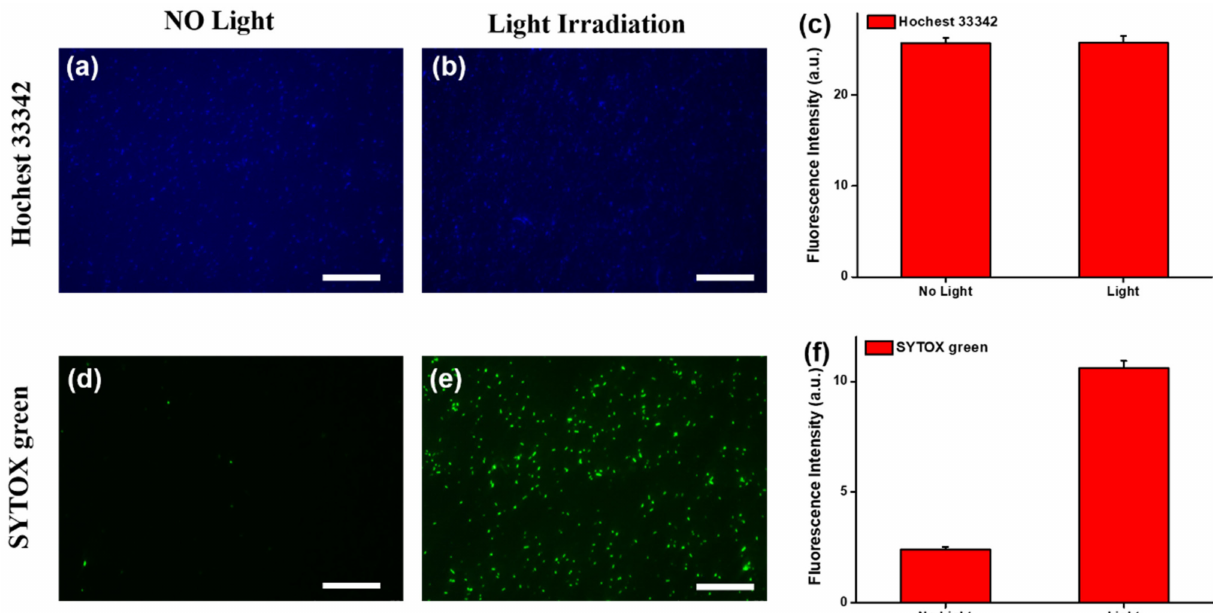
Figure 6. Fluorescence images of Hoechst 33342 for gold nanoisland films (AuNIFs) cultured with Escherichia coli ( a ) without or ( b ) with light irradiation. ( c ) Fluorescence intensities from ( a , b ). Fluorescence images of SYTOX green for AuNIFs cultured with E. coli ( d ) without or ( e ) with light irradiation. ( f ) Fluorescence intensities from ( d , e ). Scale bars are 50 µ